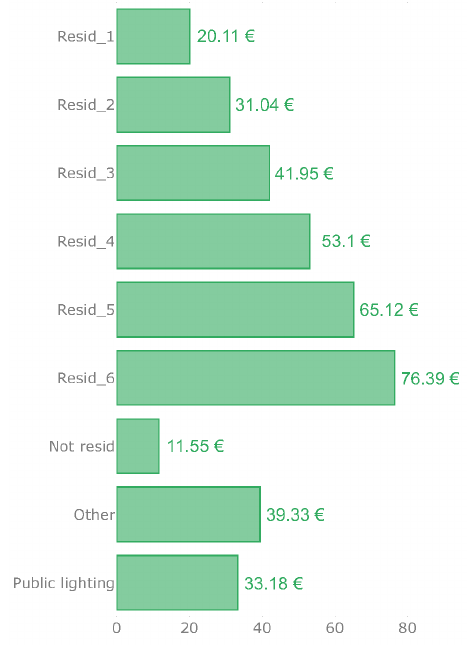
Figure 13. Yearly revenue obtained by each consumer applying redistribution